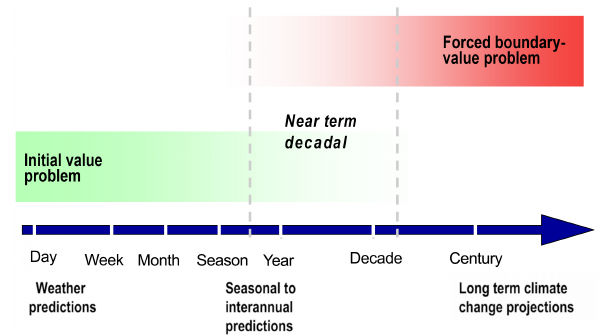
Figure 1. Predictions of interest to the Decadal Climate Predic- tion Project proceed from an initial condition problem at shorter timescales to a forced boundary-value problem at longer timescales (modified from Kirtman et al., 2013, Fig.